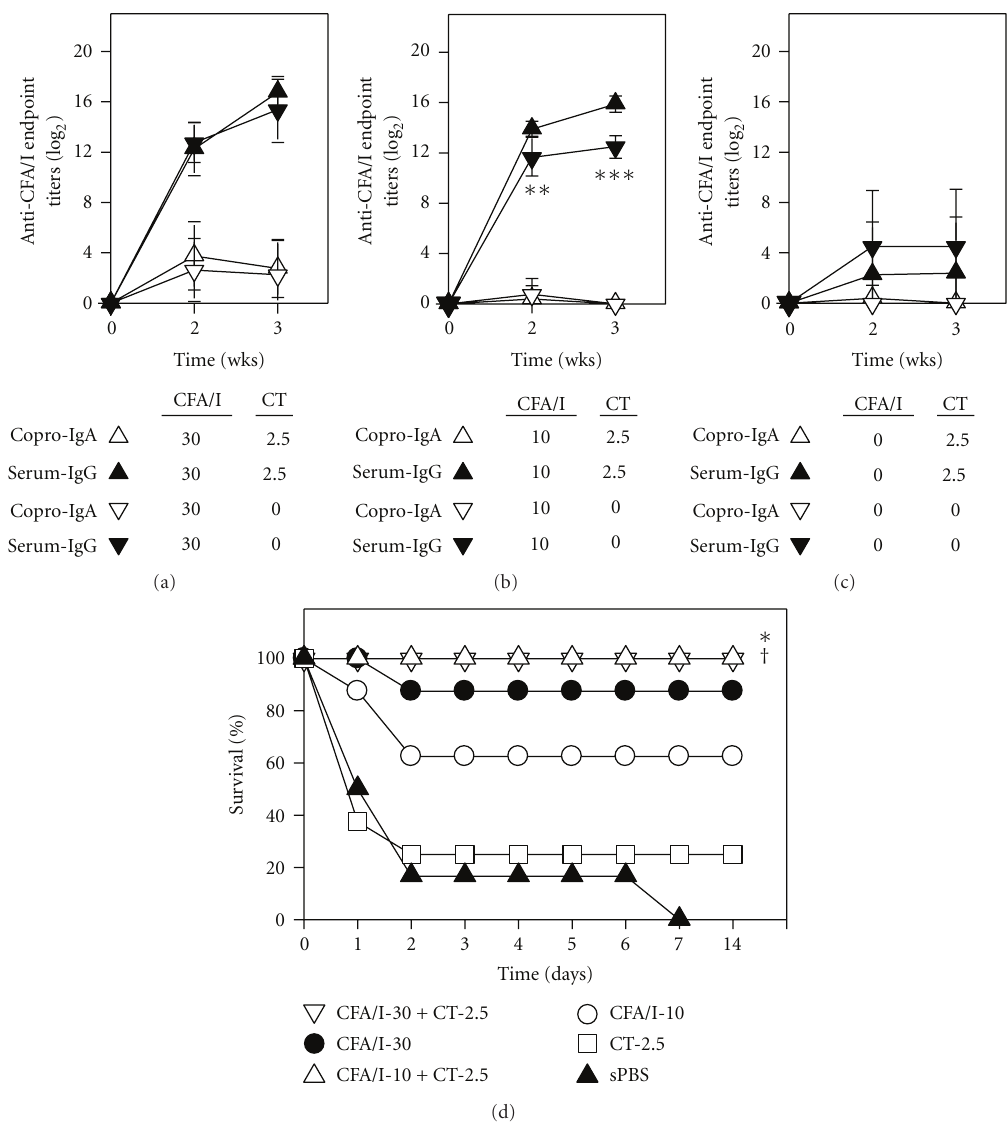
Figure 2: Evaluation of protective immunity induced by a low dose of CFA/I fimbriae. BALB/c mice (6–8/group) were i.m. immunized with (a) 30, (b) 10, and (c) 0 µ g detoxed CFA/I fimbriae with or without CT on day 0. (a, b) Elevated serum IgG and mucosal IgA anti-CFA/I Ab fimbriae responses were induced by 2wks after immunization (c), but not by control mice. Depicted is the mean ± SD as ∗∗ P < 0 . 01 and ∗∗∗ P < 0 . 001 versus 10 µ g CFA/I fimbriae-immunized mice. (d) Assessment of the protective e ffi cacy by the low-dose CFA/I fimbriae- immunized mice. The CFA/I fimbriae-immunized and sPBS-dosed mice (a)–(c) were i.p. challenged with 5 × 10 7 CFUs of wt ETEC H10407 at 4wks after immunization. Mouse survival rates were determined for 14 days. Both 30 µ g CFA/I + 2.5 µ g CT-immunized mice and 10 µ g CFA/I + 2.5 µ g CT-immunized mice survived (8/8); the survival rates for 30 µ g CFA/I- and 10 µ g CFA/I-immunized mice were 87.5% (7/8) and 62.5% (5/8), respectively; the 2.5 µ g CT-immunized mice showed 25% (2/8) survival; and the sPBS-dosed mice all succumbed to challenge (0/6). Survival fractions obtained from 30 µ g CFA/I + 2.5 µ g CT-immunized mice and 10 µ g CFA/I + 2.5 µ g CT-immunized mice were compared to sPBS-dosed mice and were determined, ∗ P < 0 . 05 and † P < 0 . 05,